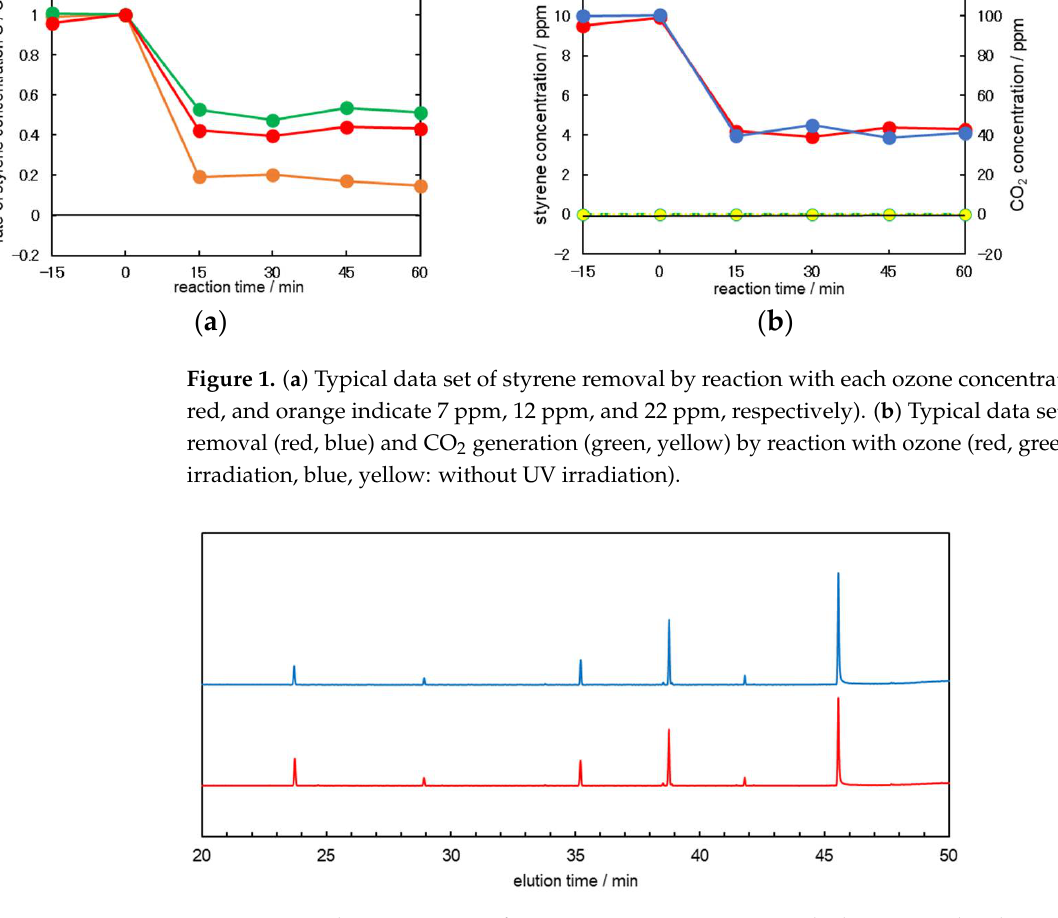
Figure 2. Gas chromatograms of gas components at reactor outlet by activated carbon tube–solvent extraction method (red: with ozone and UV irradiation, blue: with ozone only).